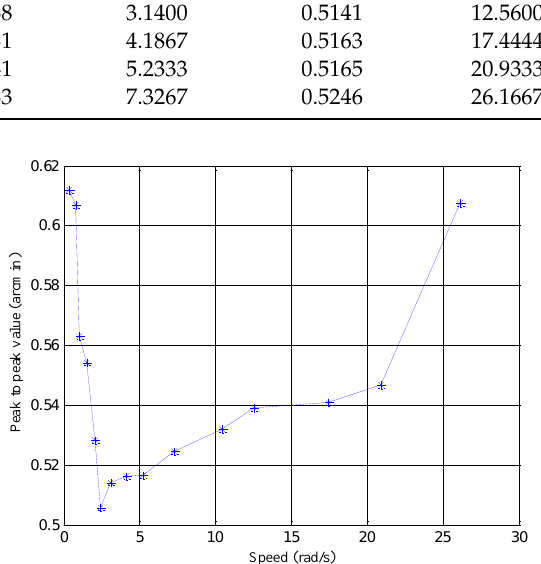
Figure 8. Variations of the peak-to-peak value of transmission errors with